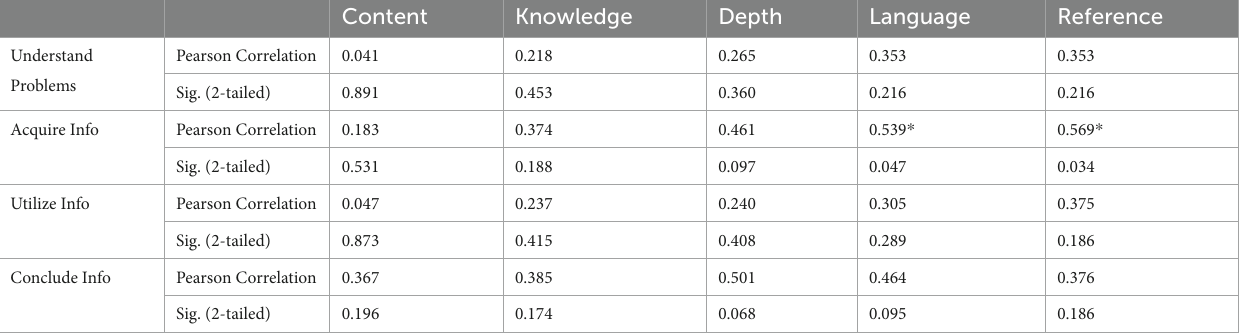
TABLE 5 Relationships between the dimensions of critical thinking and academic writing skills.